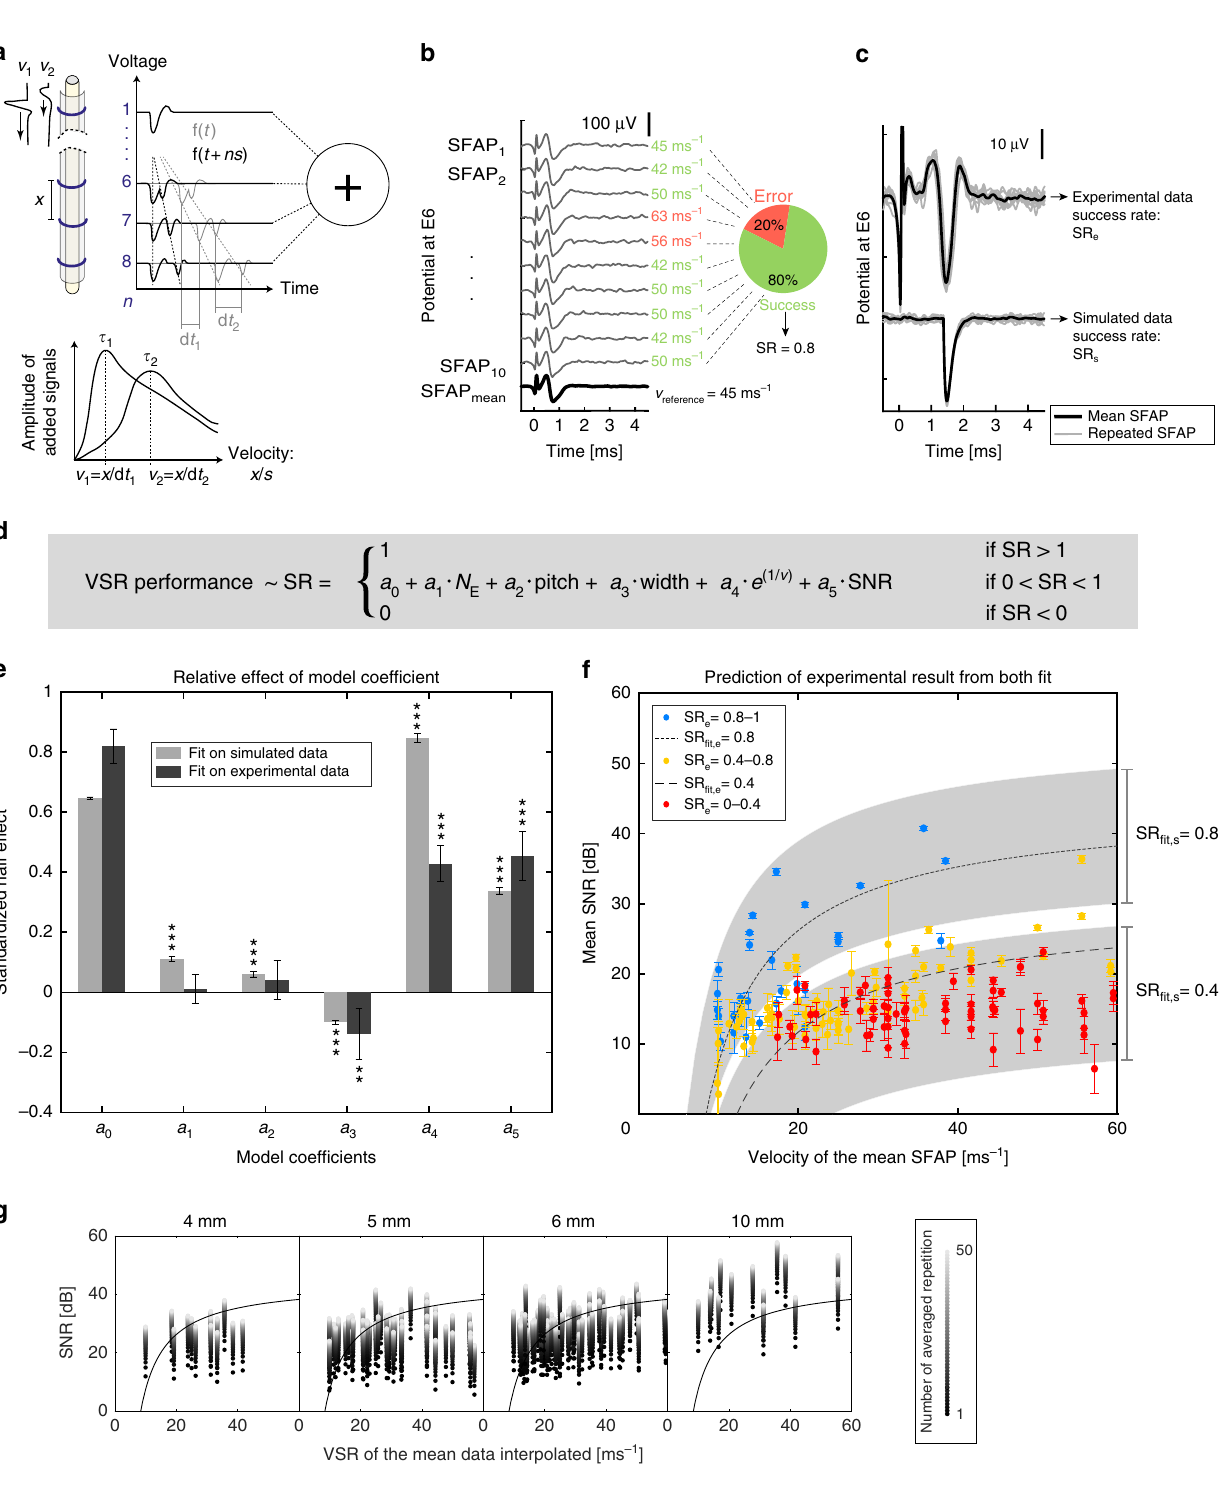
Supplementary Fig. 9. Calculation was done based on a velocity threshold of 5 ms – 1 (calculation details in